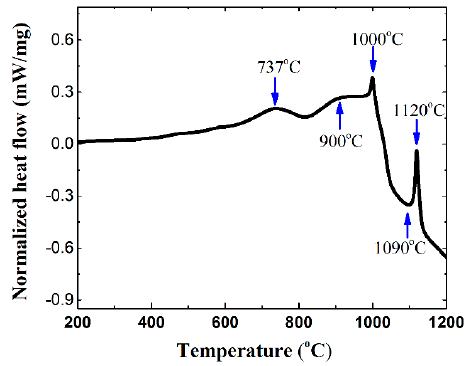
Figure 3. The details of DTA curve of 20 wt % Ni-Ti-C green body at a heating rate of 5 °C/min.